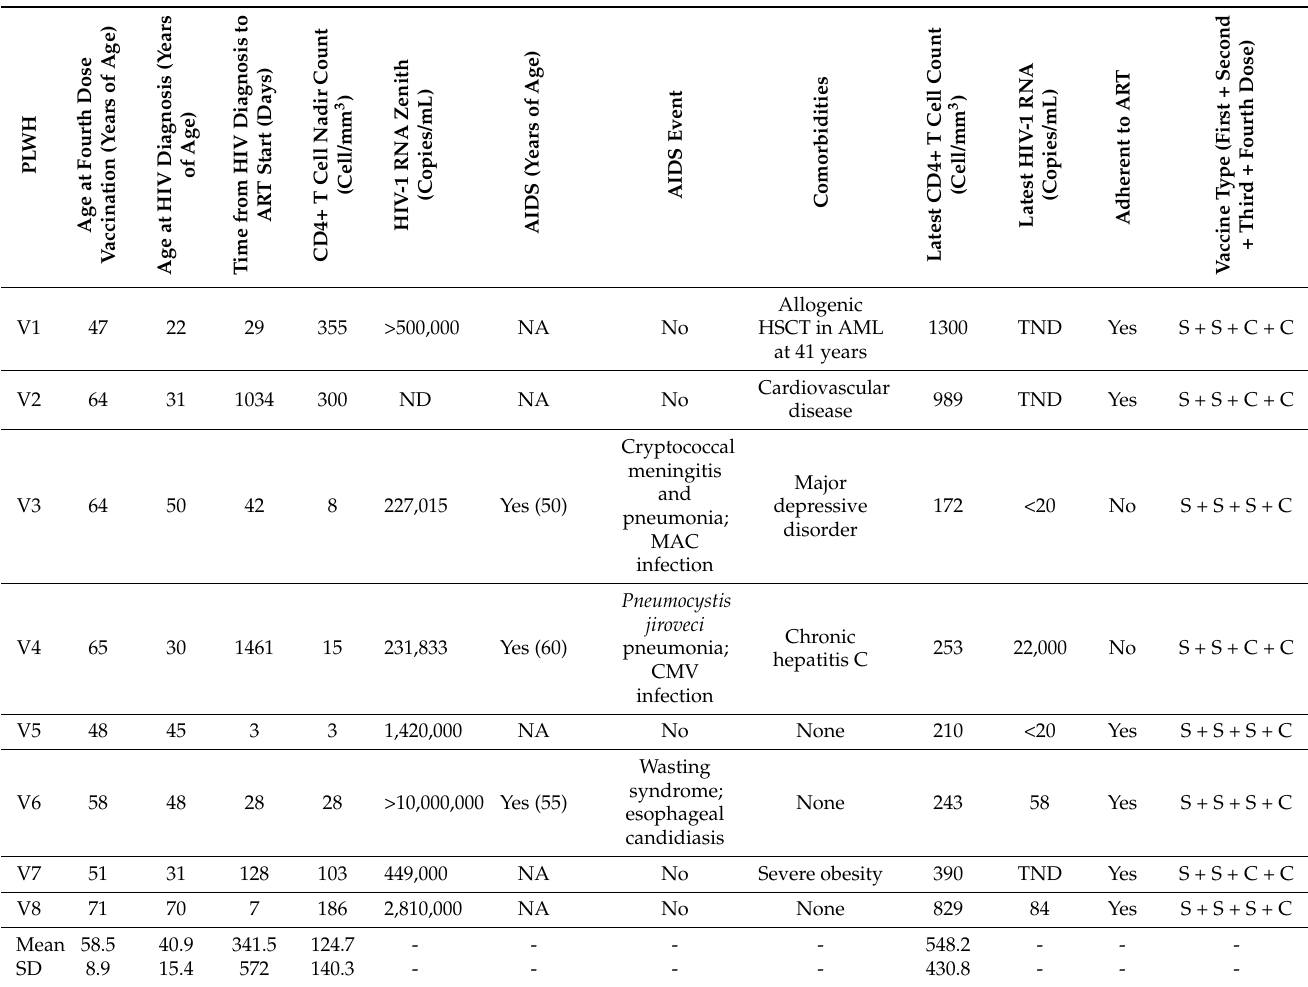
Table 1. Demographic and clinical features of eight people living with HIV (PLWH), who received the fourth anti-SARS-CoV-2 mRNA vaccine dose. V: vaccinee; AIDS: acquired immunodeficiency syndrome; AML: acute myeloid leukemia; C: original BNT162b2 vaccine; ART: antiretroviral therapy; HSCT: hematopoietic stem cell transplantation; MAC: mycobacterium avium complex; NA not applicable; ND not determined; S: original mRNA-1273 vaccine; SD: standard deviation; TND: target not